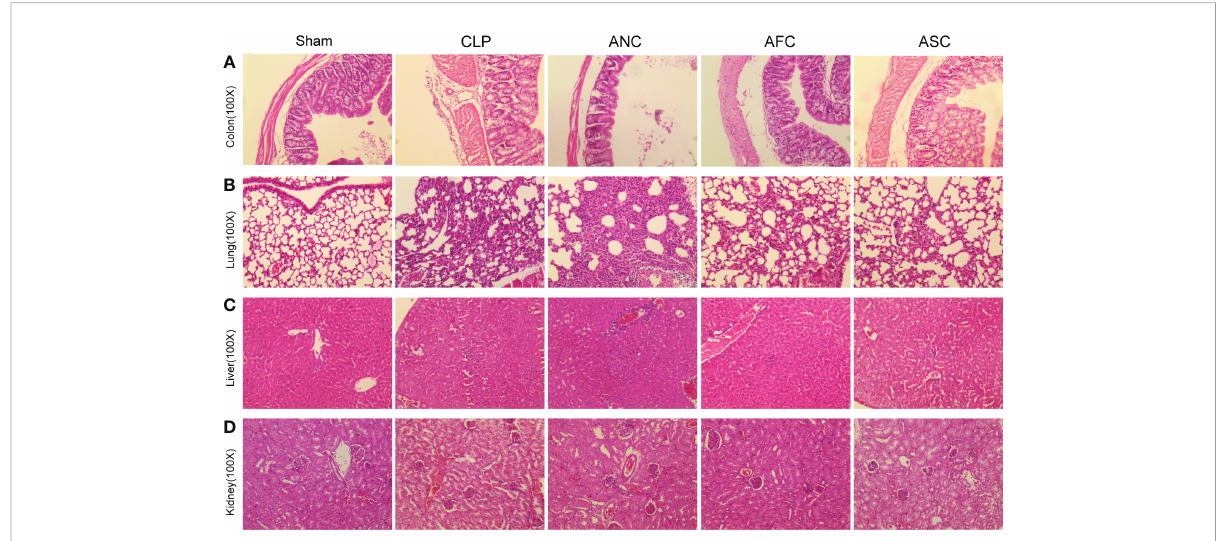
FIGURE 3 Fecal microbiota transplantation (FMT) and supplementation with short-chain fatty acids (SCFAs) prevent sepsis in mice against organ failure. (A-D) H&E staining revealed considerably higher levels of in fl ammatory in fi ltration, edema, and bleeding in the colon, lung, liver, and kidney tissue of the ANC group compared to the Sham group, but these abnormalities were drastically reduced in the AFC and ASC groups, originally magni fi cation,